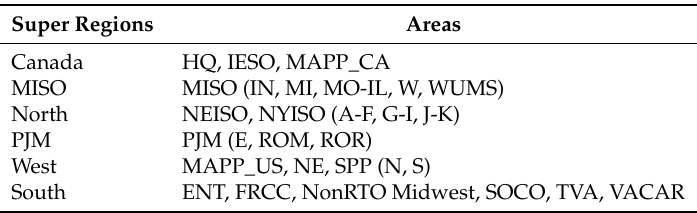
Table 4. Super regions’